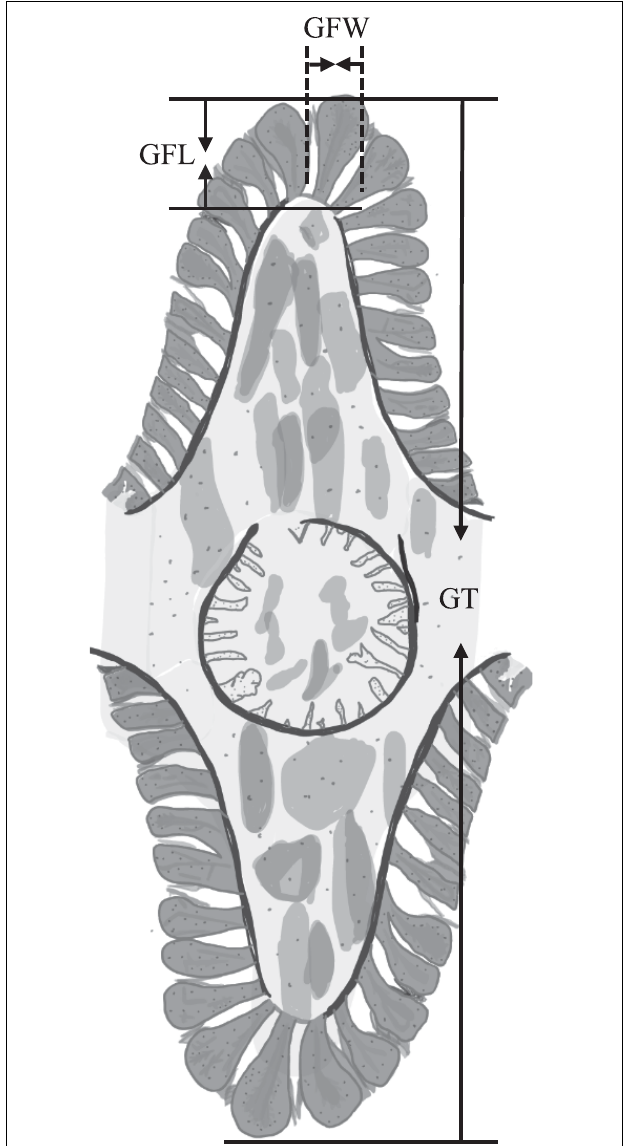
FIGURE 1 | Schematic diagram of the gill of Sinonovacula constricta . GFL, gill filament length; GFW, gill filament width; GT, gill thickness.